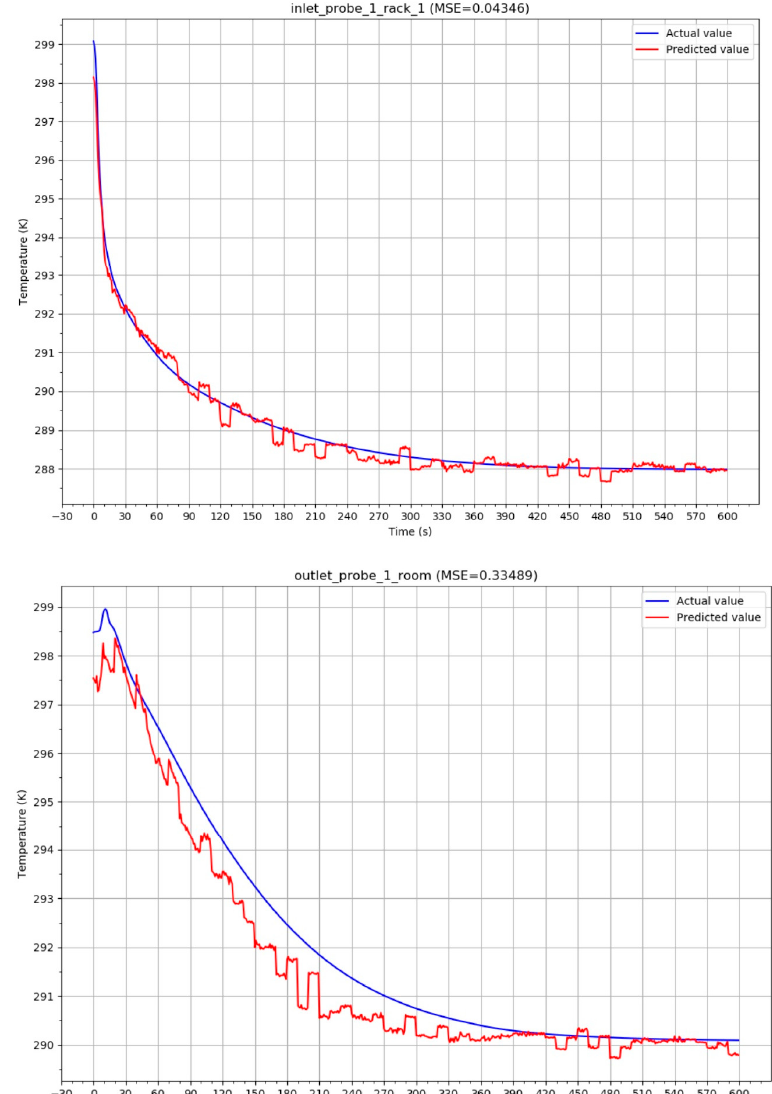
Figure 10. Predicted temperature (with RED) compared with the temperature determined with CFD simulation (with BLUE): TOP— T HOTAIR at rack 1, inlet 1, probe 1; BOTTOM— T HOTAIR at room outlet probe 1.